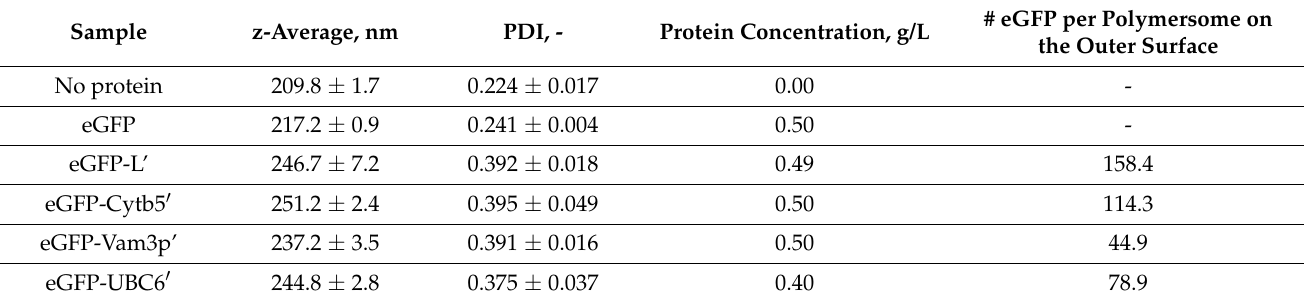
Table 1. Dynamic light scattering measurements of polymersomes functionalized with membrane-anchoring eGFP. Errors represents the standard deviation in technical